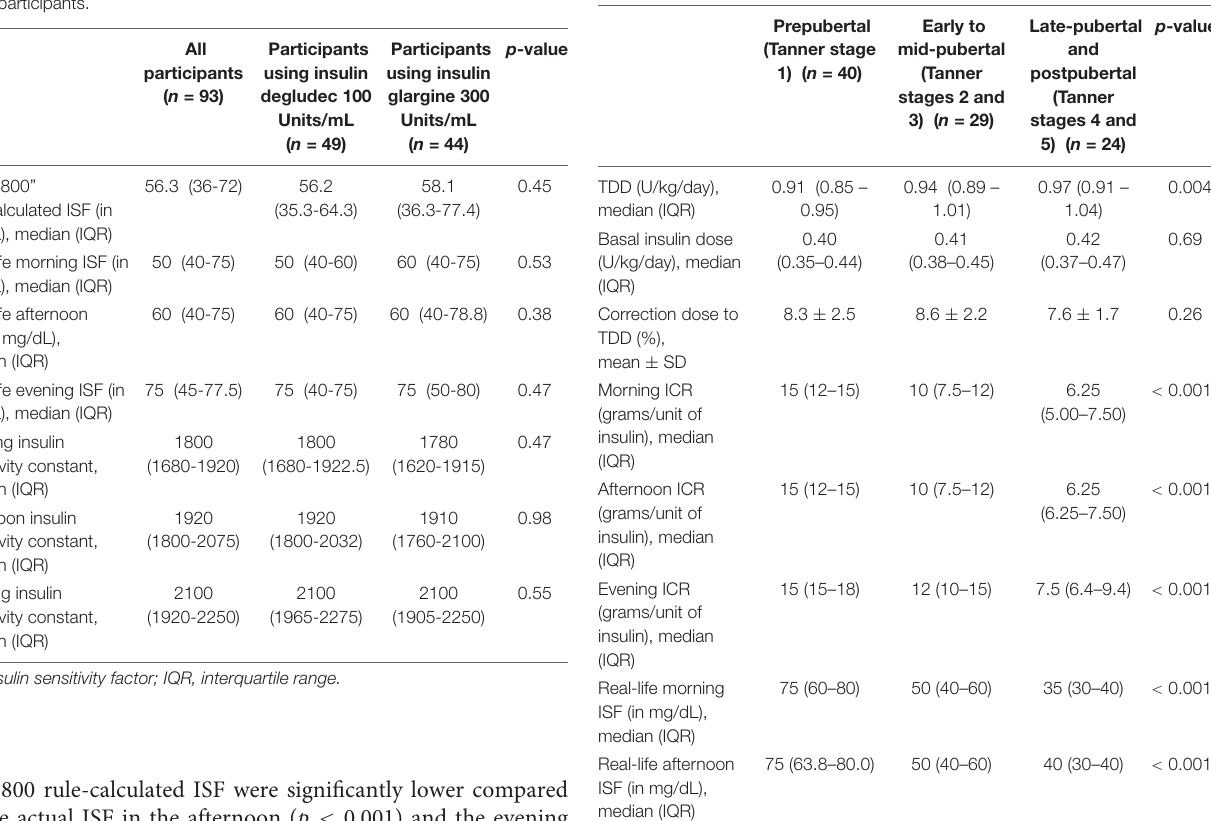
TABLE 4 | Insulin doses, insulin-to-carbohydrate ratio and insulin sensitivity factor for the study participants according to their pubertal